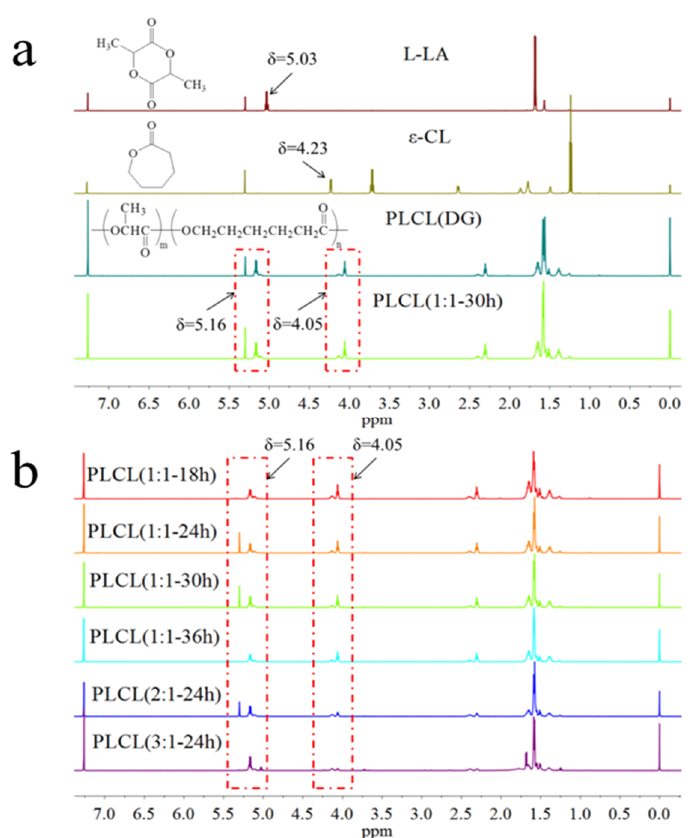
Figure 2. 1 HNMR spectra of L-lactide (L-LA), ε-caprolactone (ε-CL), PLCL (DG), and PLCL (1:1-30 h) ( a ); 1 HNMR spectra of PLCL copolymers synthesized at different conditions ( b Table 1. Characterization of PLCL (DG) and PLCL copolymers synthesized at different conditions.